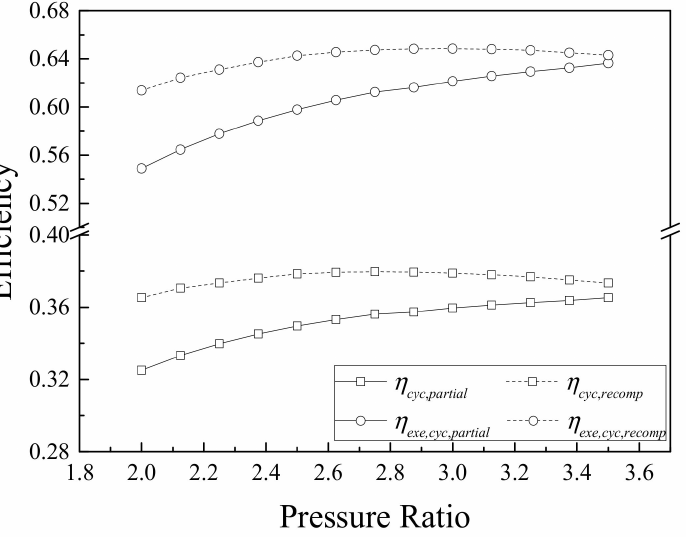
Figure 7. Effects of β on η cyc and η exe , cyc with the partial-cooling cycle compared with the recompres- sion